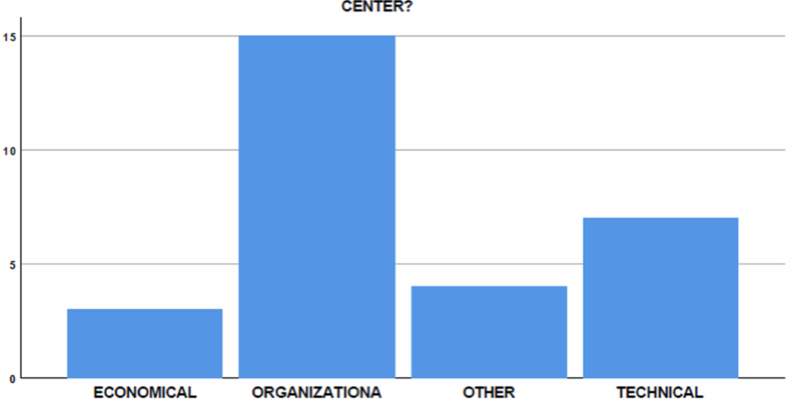
Figure 10. Perceived obstacles to diffusion of the technique in different centers.